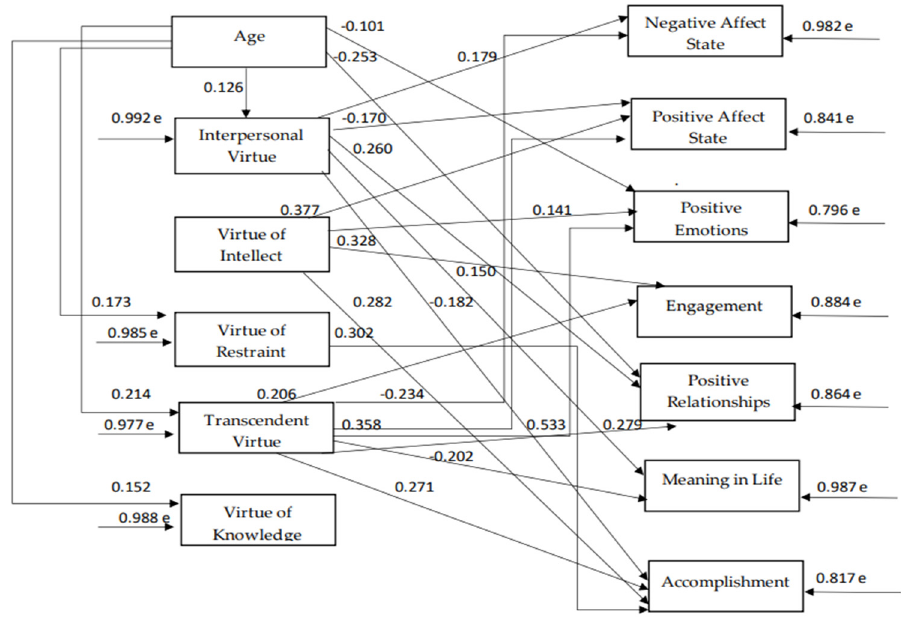
Figure 7. The relationships between demographics, virtues, and subjective wellbeing components.